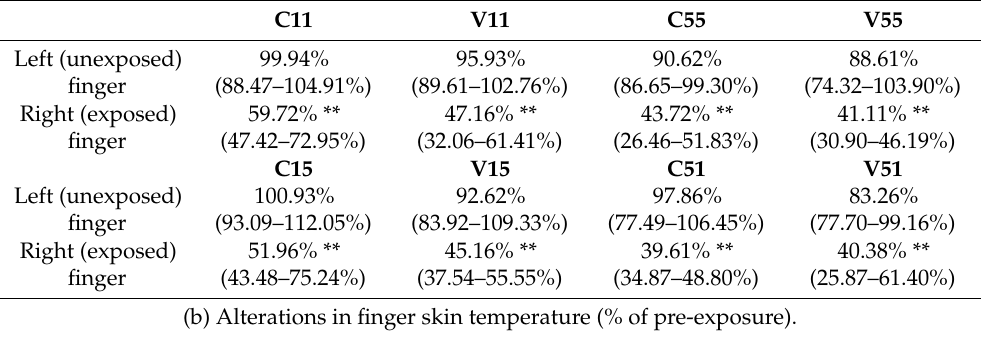
Table 2. Alterations in finger blood flow and finger skin temperature. Percentage change in FBF and FST (% of pre-exposure) for left and right fingers over eight exposure conditions. The alterations in FBF were calculated as the differences between the mean value of the median FBF in two fingers of each hand at exposure period 2 and the resting level of FBF during pre-exposure; the alterations in FST were calculated as the differences between the median FST at the first minute during recovery and the resting level of FST during pre-exposure. Values given in parentheses are the range of quartiles (namely,